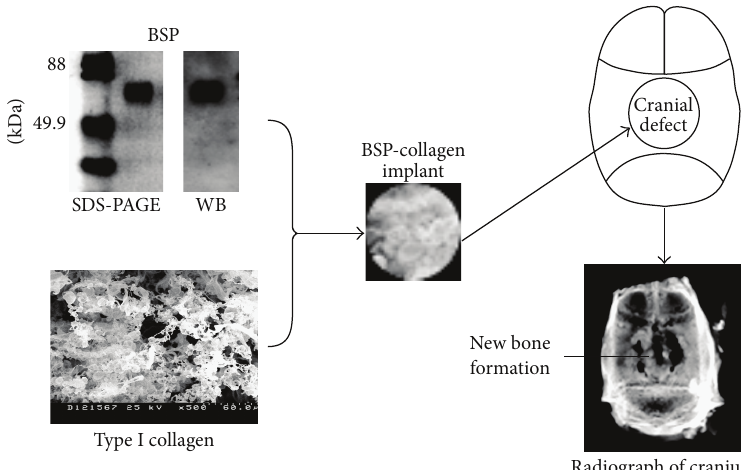
Figure 2: BSP-collagen implant preparation and implantation. A diagram shows the process of BSP-collagen implant preparation, BSP- collagen implantation into a rat calvarial bone defect and new bone formation in the defect at day 30 after implantation of